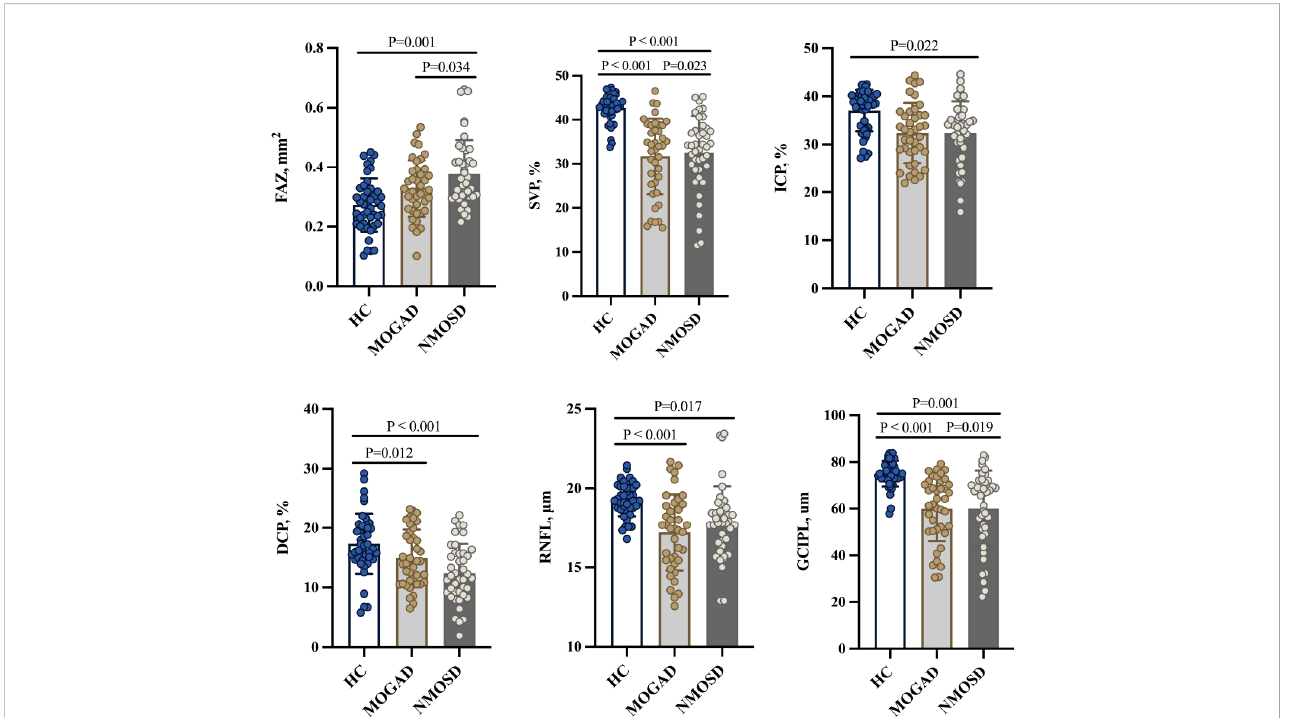
FIGURE 2 Comparison of OCT/OCTA parameters. FAZ, foveal avascular zone; SVP, super fi cial vascular plexus; ICP, intermediate capillary plexus; DCP, deep capillary plexus; RNFL, retinal nerve fi ber layer; GCIPL, ganglion cell and inner plexiform layer; HC, healthy control; MOGAD, myelin oligodendrocyte glycoprotein antibody disease; NMOSD, neuromyelitis optica spectrum